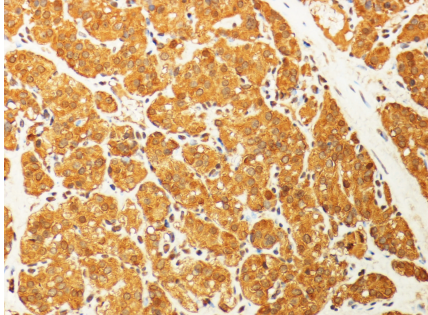
Figure 3: Immunostaining for chromogranin A showed strong and di ff use positivity in the tumor cell cytoplasm